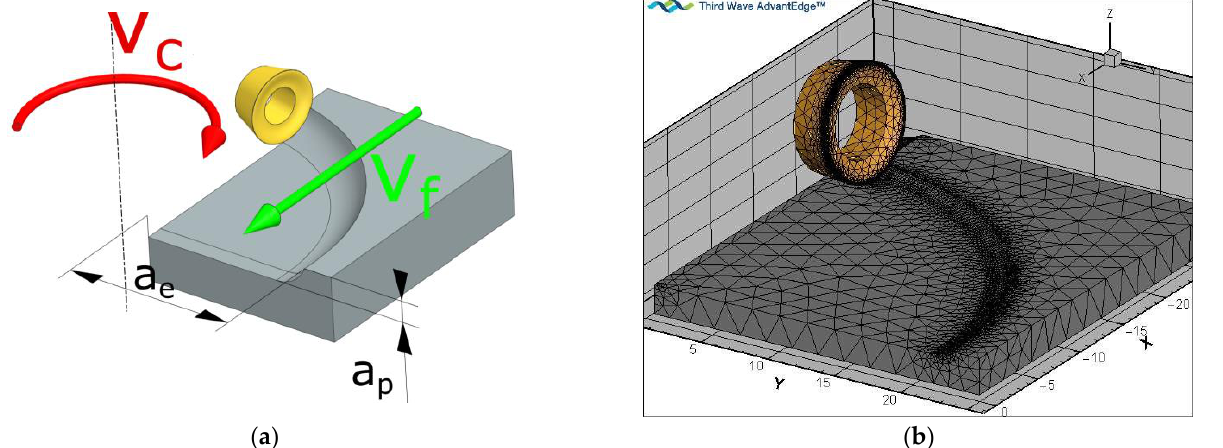
Figure 3. Kinematics of the milling process: ( a ) milling parameters; ( b ) finite element mesh.